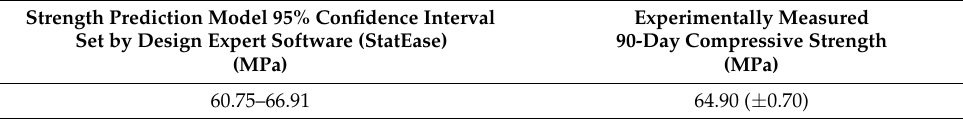
Table 7. The 90-day compressive strengths of the mixes for model validation.